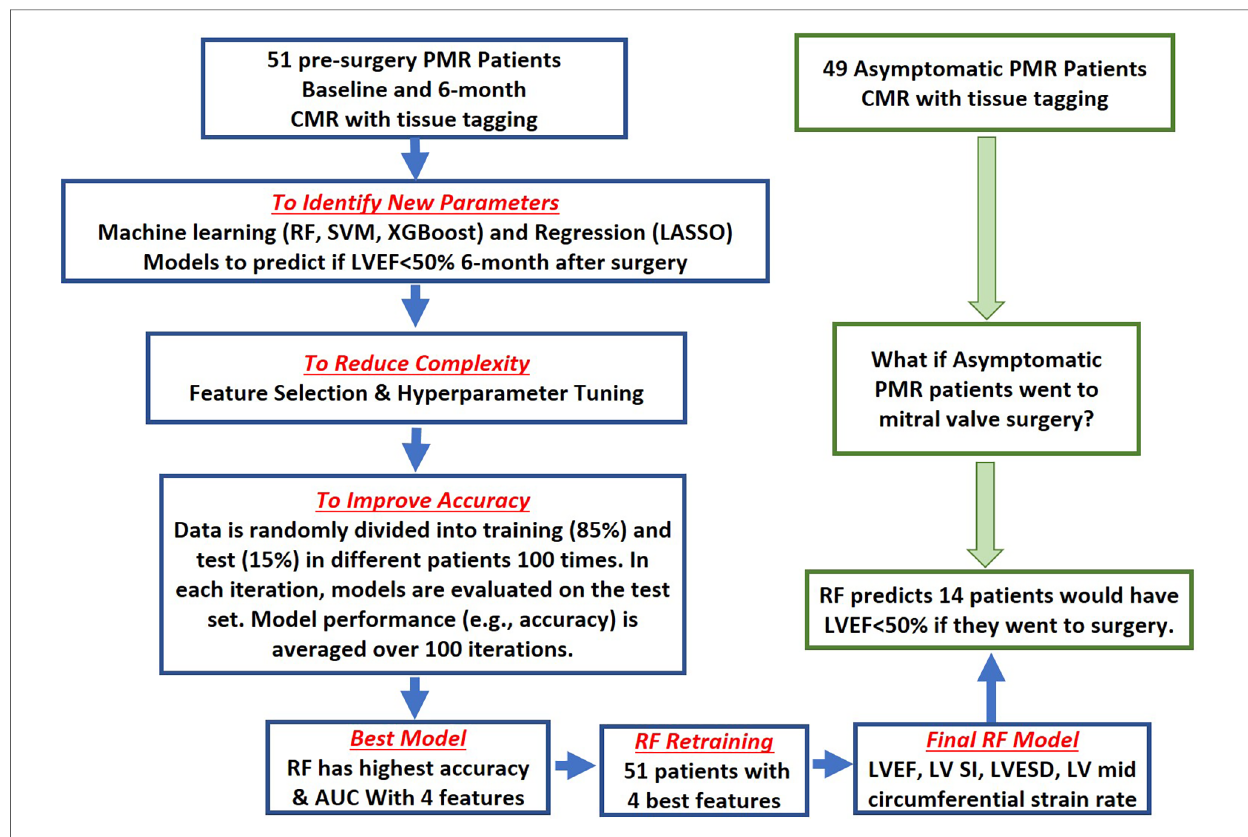
FIGURE 2 Flow chart of proposed model training and validation process. 51 pre-surgery and 49 asymptomatic PMR patients were recruited between 2005 and 2010. Random sampling was performed in pre-surgical patients to generate balanced data. Training ( n =43) and Testing Sets ( n =8) were established (blue fl ow chart). For each model, feature selection identi fi ed a subset of features relevant in predicting post-surgical LVEF <50% using LASSO, or the machine learning models: random forest (RF), support vector machine (SVM), and extreme gradient boosting (XGBoost) models. Random forest had the highest area under the curve and accuracy and was chosen as the best predictive model. Based on the top 4 predictive features [LVEF, LV Sphericity Index (SI), LVESD and LV systolic circumferential strain rate], the RF model was retrained on the 51 pre-surgery PMR patents then applied to 49 asymptomatic PMR patients to predict LVEF<50% (14 patients — 28%) if they were to have mitral valve surgery (green fl ow